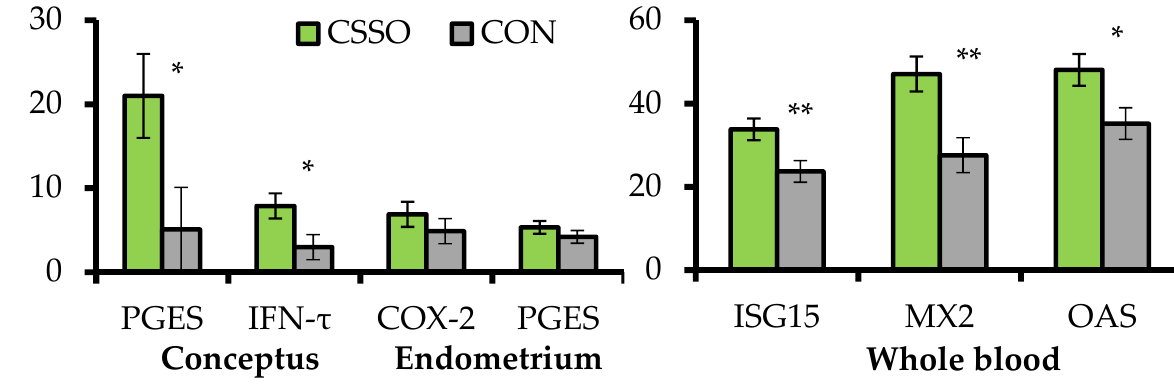
Figure 2. Expression of mRNA (relative fold change) in genes associated with pregnancy establishment in conceptus and endometrial samples collected on day 15 of gestation, and whole blood collected on day 20 of gestation from B. indicus cows receiving or not (CON; n = 10) Ca soaps of soybean oil (CSSO; n = 10) after artificial insemination. PGES = prostaglandin E synthase ; IFN- τ = interferon-tau; COX-2 = cyclooxygenase-2 ; ISG15 = interferon-stimulated gene 15 ; MX2 = myxovirus resistance 2 ; OAS = 20 , 50 - oligoadenylate synthetase . All values reported are least square means ± standard error (represented as error bars). Within variable, ** p < 0.01 and * p ≤ 0.05. Adapted from Cipriano et al. [20].